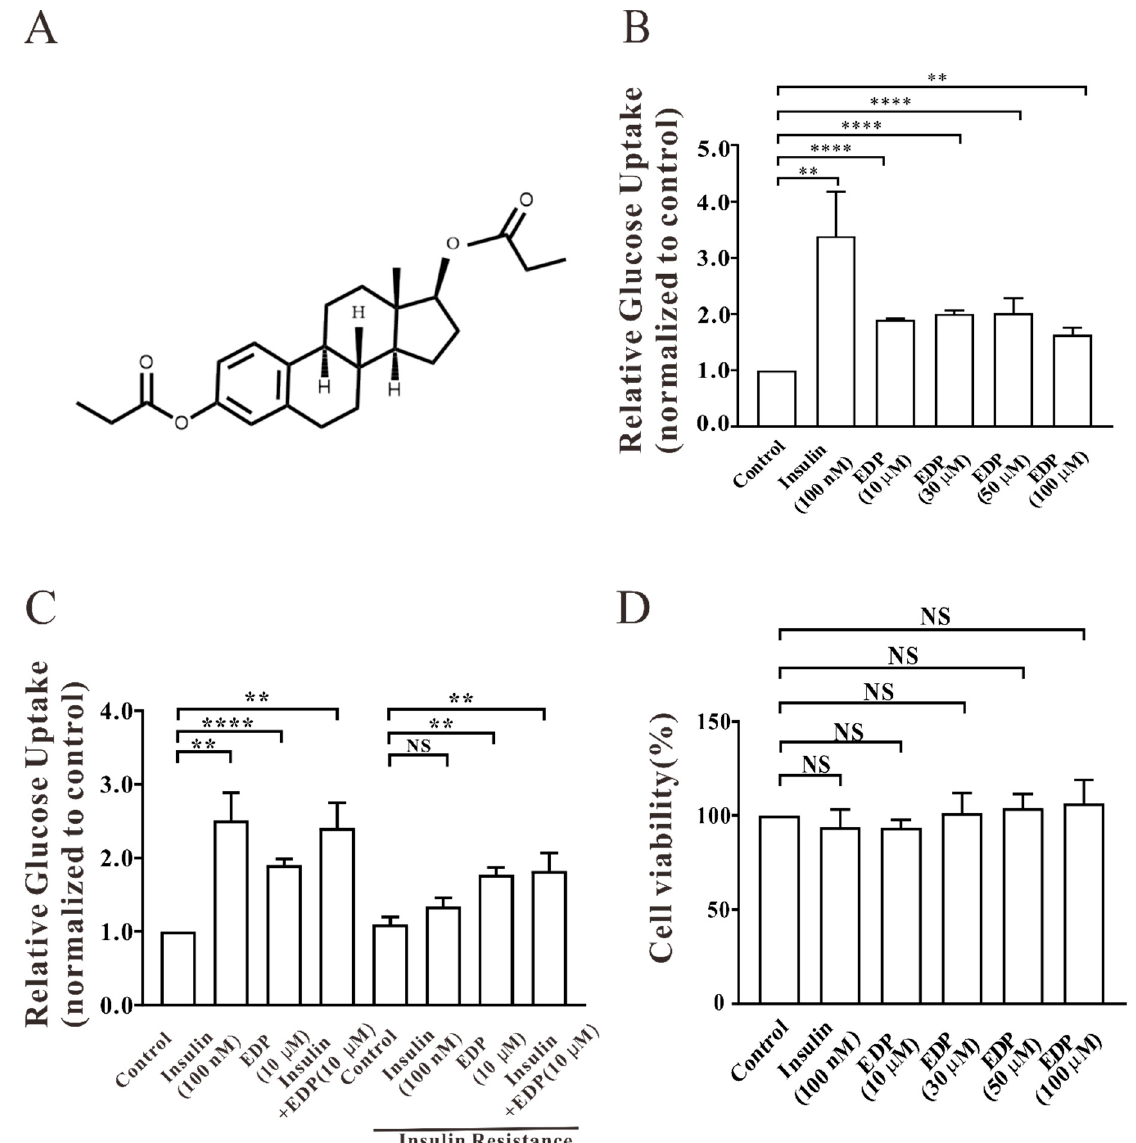
Figure 1. Estradiol Dipropionate (EDP) promotes uptake of glucose in L6 cells. ( A ) Chemical structure of EDP; ( B ) 10 μ M EDP increases uptake of glucose in L6 cells within 30 min; ( C ) 10 μ M EDP increased uptake of glucose in insulin resistant models within 30 min; ( D ) the toxicity of EDP to cells was detected within 30 min. NS p > 0.05; ** p < 0.01; **** p < 0.0001.